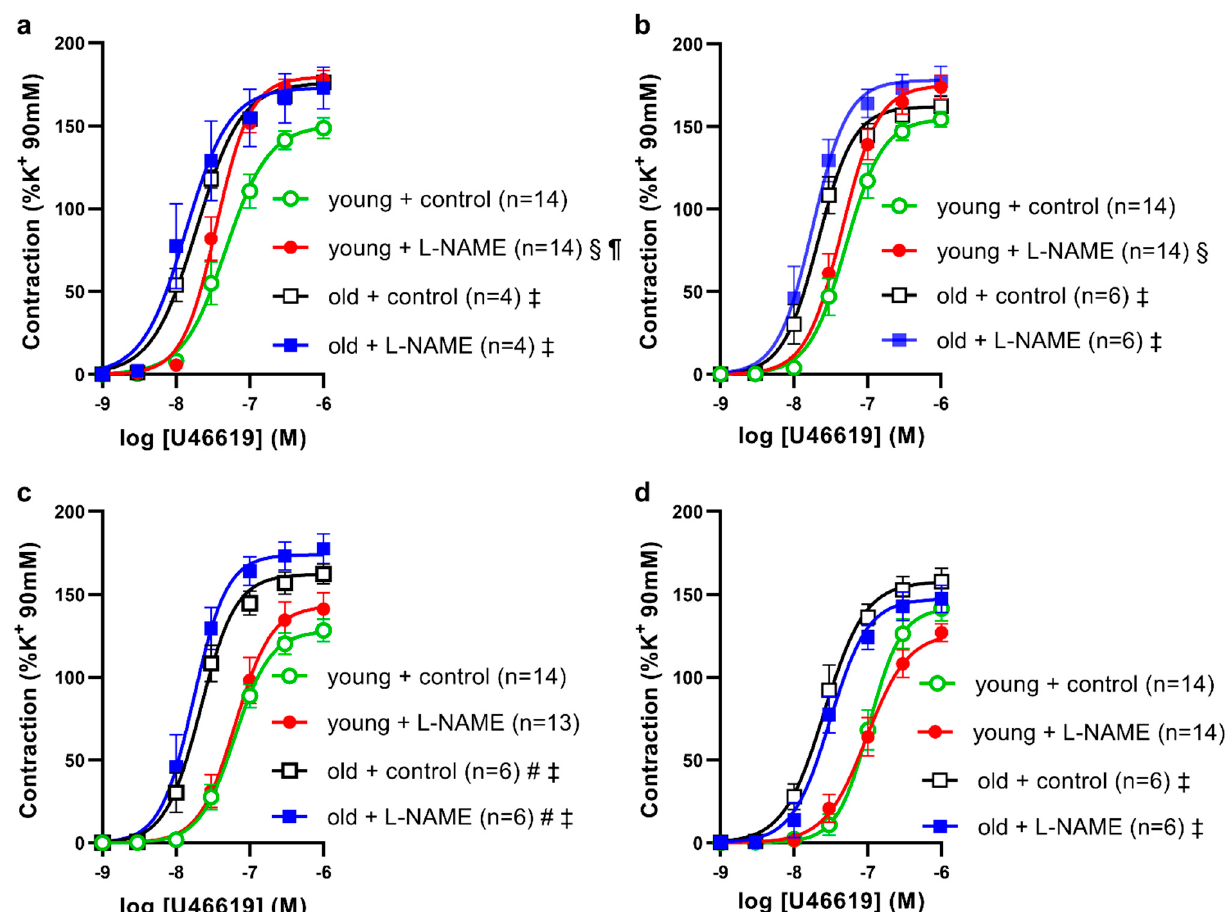
Figure 3. The effects of NO synthase inhibitor L-NAME on U46618-induced contractions of ( a ) proximal, ( b ) middle, ( c ) distal saphenous artery segments, and ( d ) caudal branches from (circle symbols) young and (square symbols) old Sprague Dawley rats. The results are expressed as mean ± S.E.M of ( n ) rats. Differences in best-fit curve parameters were compared by 2-way ANOVA, followed by Bonferroni post-hoc test. Lines represent best-fit four parameter sigmoidal dose response curves. # p < 0.05, vs. E max young + control; ‡ p < 0.05, vs. − log EC 50 young + control; § p < 0.05, E max L-NAME vs. control; ¶ p < 0.05, − log EC 50 L-NAME vs. control. Table 3. The effect of pretreatment with L-NAME (100 µM) on U46619 concentration–response curves in the saphenous artery segments and caudal branches from young and old Sprague Dawley rats.